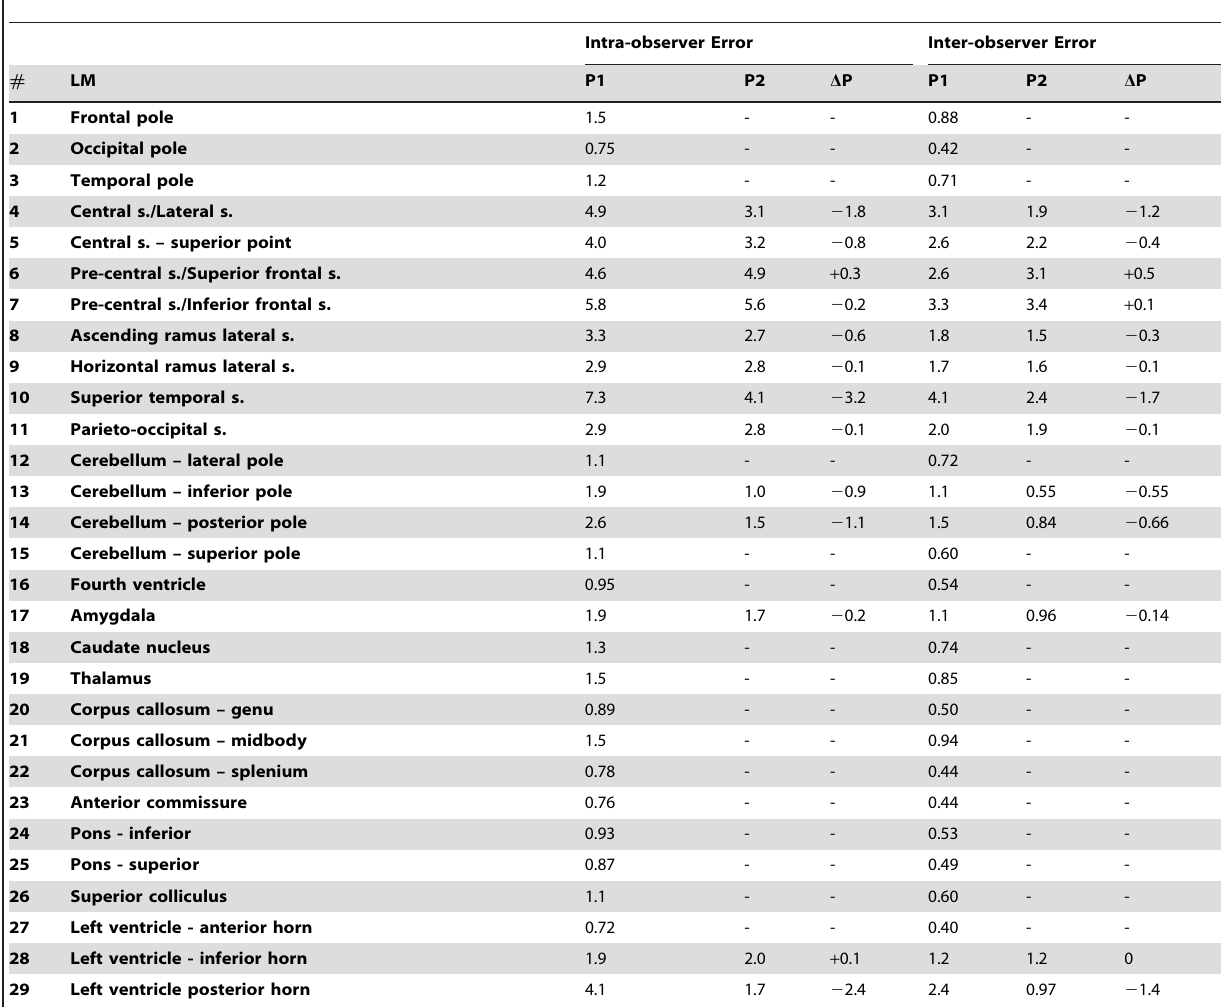
Table 2. Average intra-observer error and inter-observer error measured for